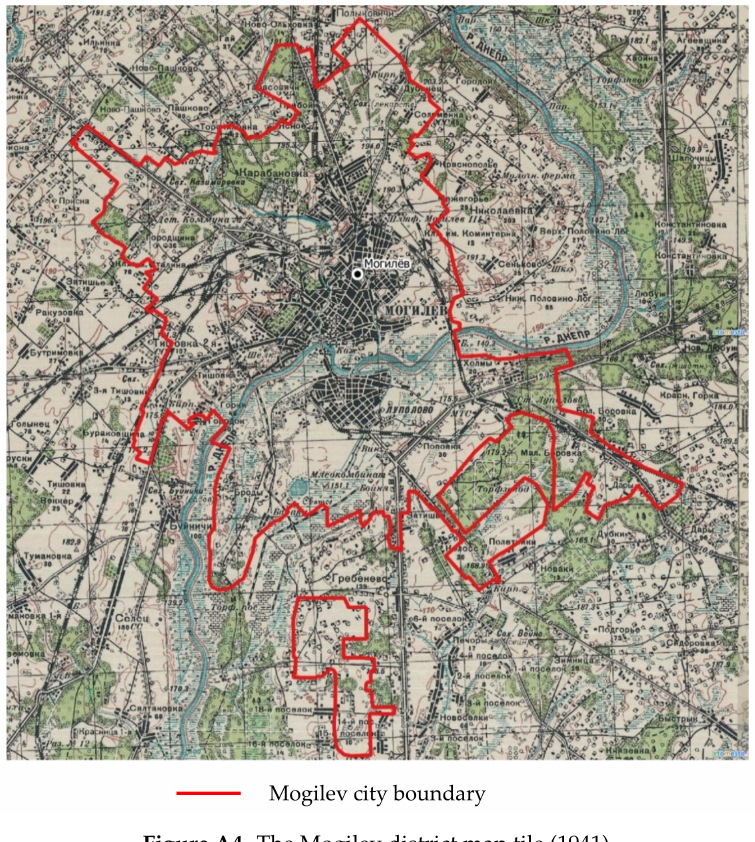
Figure A4. The Mogilev district map tile (1941).